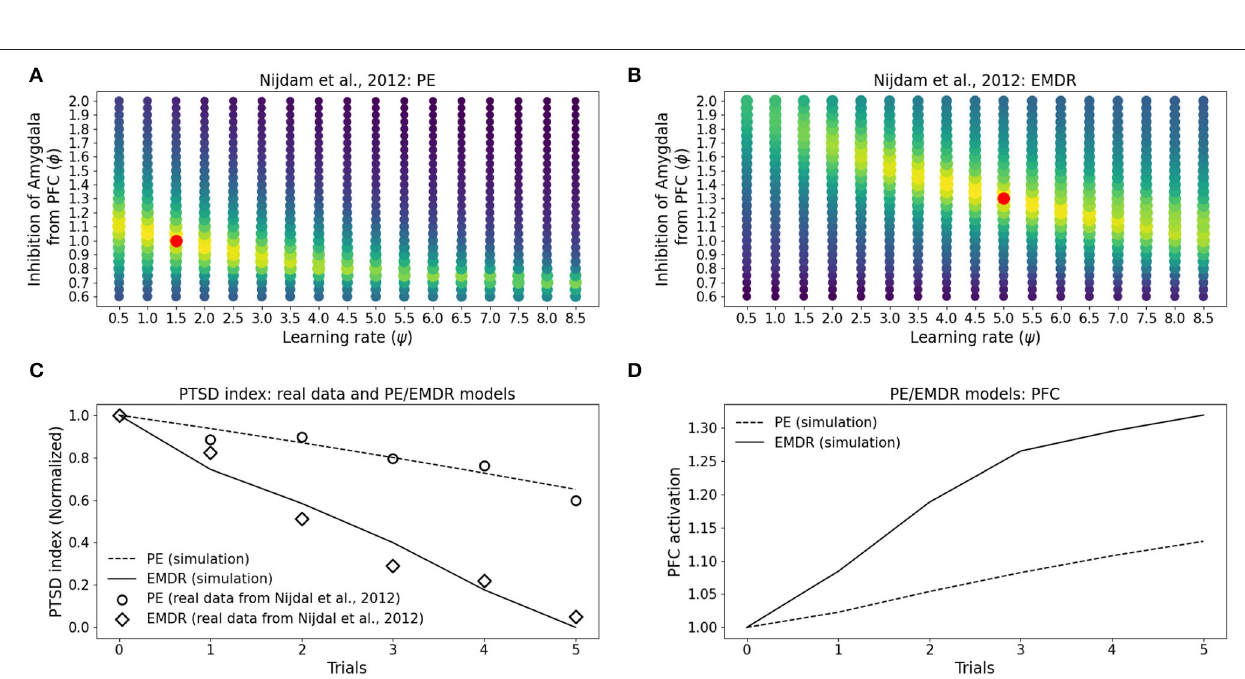
FIGURE 8 | Eye movement desensitization and reprocessing therapy is compared to PE therapy. Each dot in (A,B) represents a simulation to fit the data of PE (A) and EMDR (B) in Nijdam et al. (2012). The size and the color (from blue to yellow) of the dots are proportional to the root square MSE: the best fitting model is marked by a red dot. (C) Comparison between the symptoms remission curves obtained with the model, using the parameter combinations indicated by the red dots in graphs (A) PE and (B) EMDR, and the actual experimental data from Nijdam et al. (2012). For the real data, the PTSD index is represented by the normalized IES-R score (Nijdam et al., 2012; refer to Section 3.4); in the model, the PTSD index represents the normalized amygdala unit activation following the presentation of the reminder cue. (D) PFC activation in correspondence to the simulation trials in (C) .